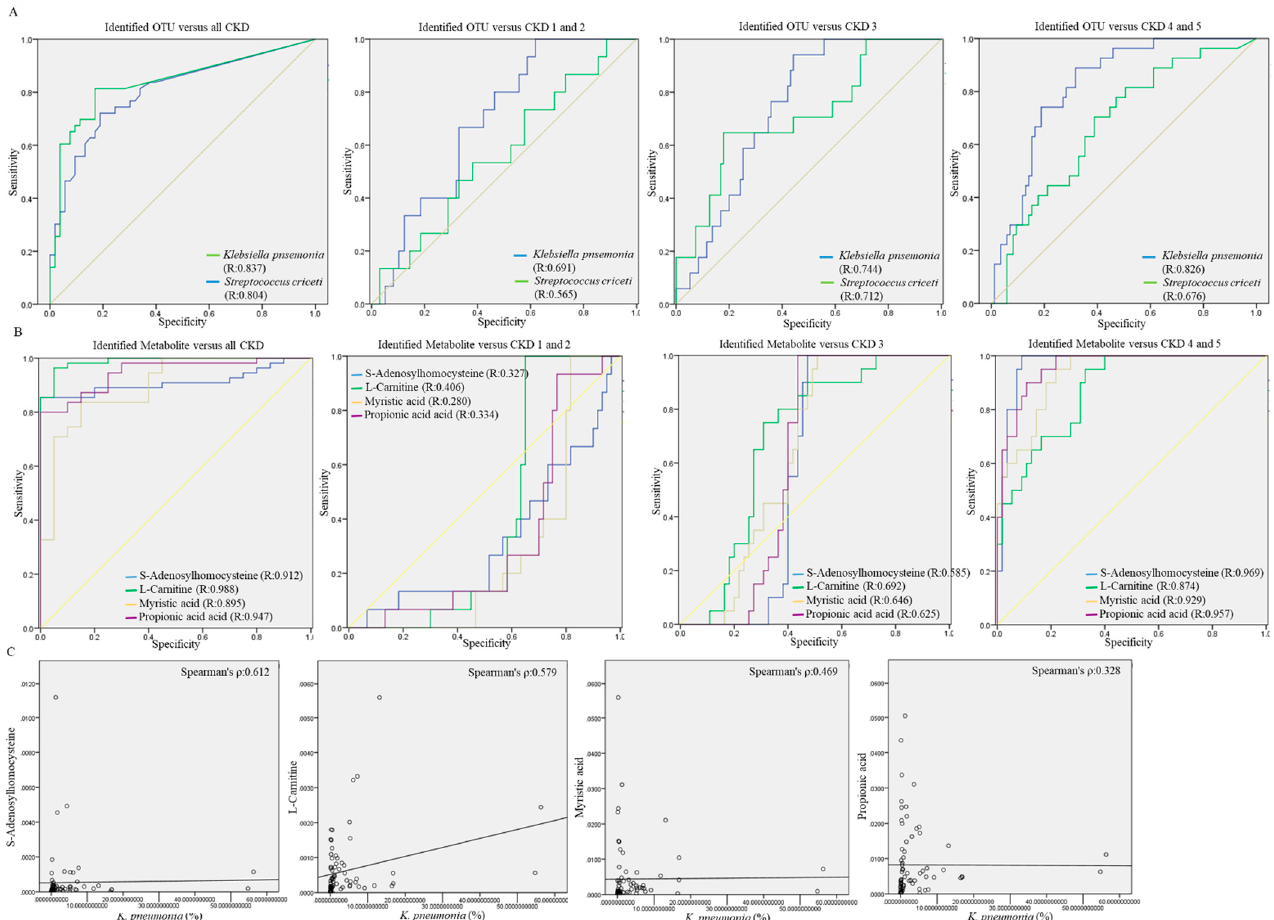
Figure 8. Predictive performances of identified OTUs or fecal metabolites toward the occurrence of chronic kidney disease (CKD) were evaluated using the random forests model. The area under the receiver operating characteristics (ROC) curve (AUC) was applied for differentiating all CKD patients or severity-specific CKD patients from the healthy group with ( A ) the relative abundances of identified OTUs or ( B ) the intensity of identified metabolites in fecal samples. ( C ) The correlation of severity-specific OTUs with the intensity of fecal metabolites was evaluated using the Spearman’s correlation co- efficient.